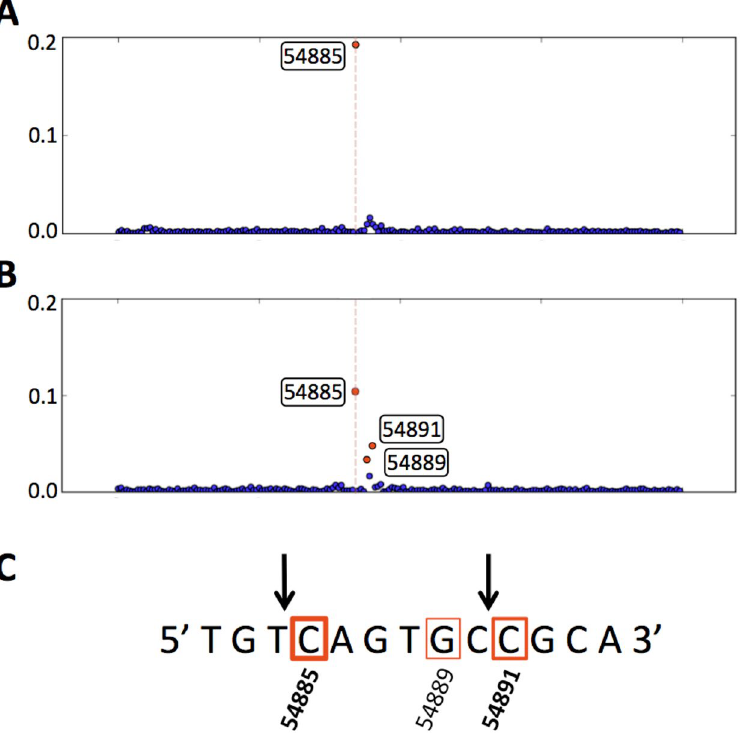
Figure 4. Bacteriophage P1 presence of secondary termini. Scatter plot of τ around the termini positions ( A ) with default surrounding option (20): one significant peak at location 54885 and ( B ) with surrounding option to 0: two close significant peaks appear. ( C ) Bacteriophage P1 DNA terminus region, arrows above represent the two main cleavage sites defined by Sternberg and Coulby in 1986, red boxes represent the significant termini found by